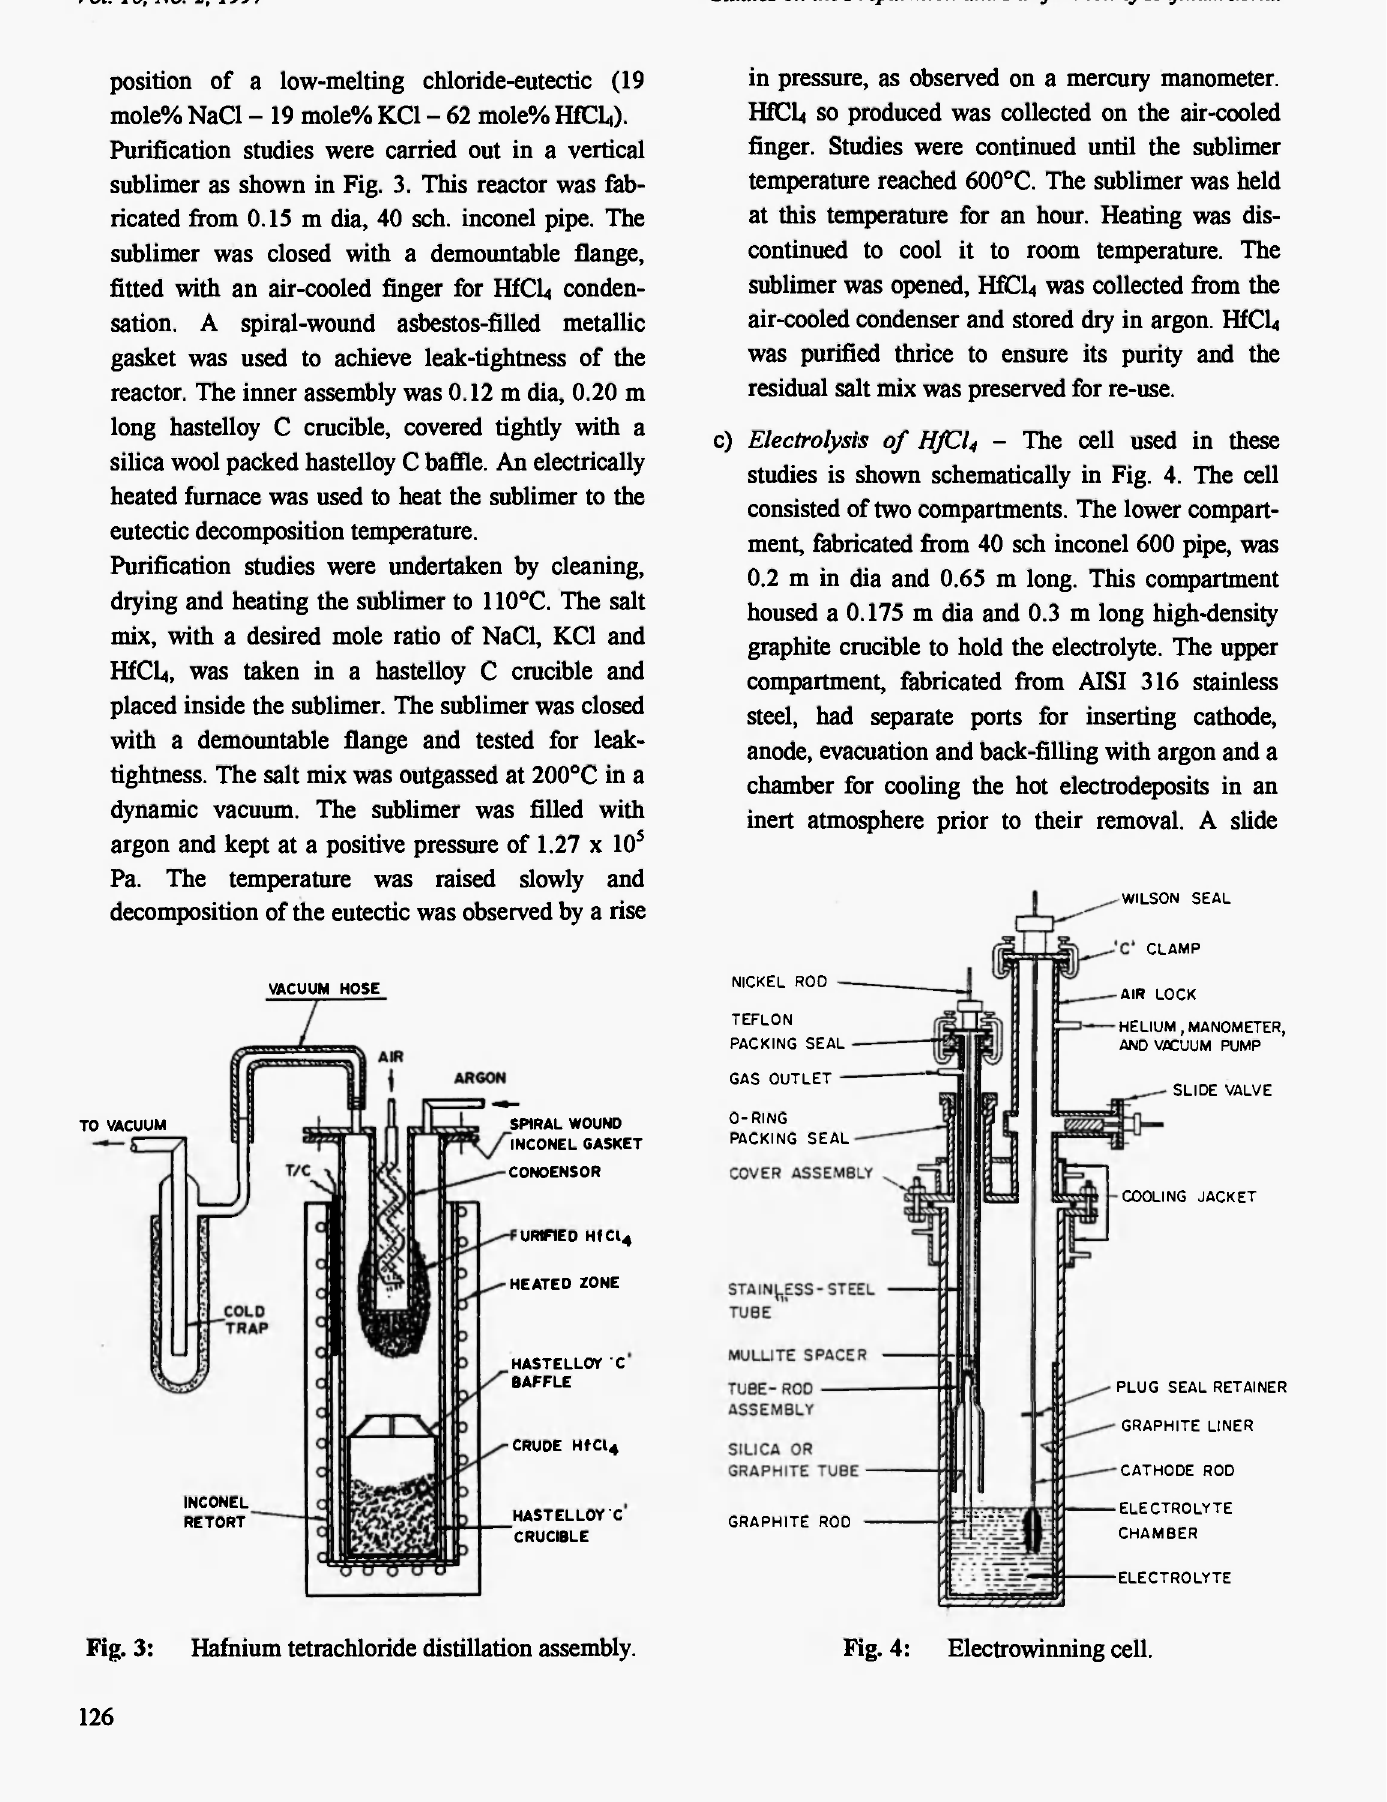
Fig. 3: Hafnium tetrachloride distillation assembly. Fig. 4: Electrowinning